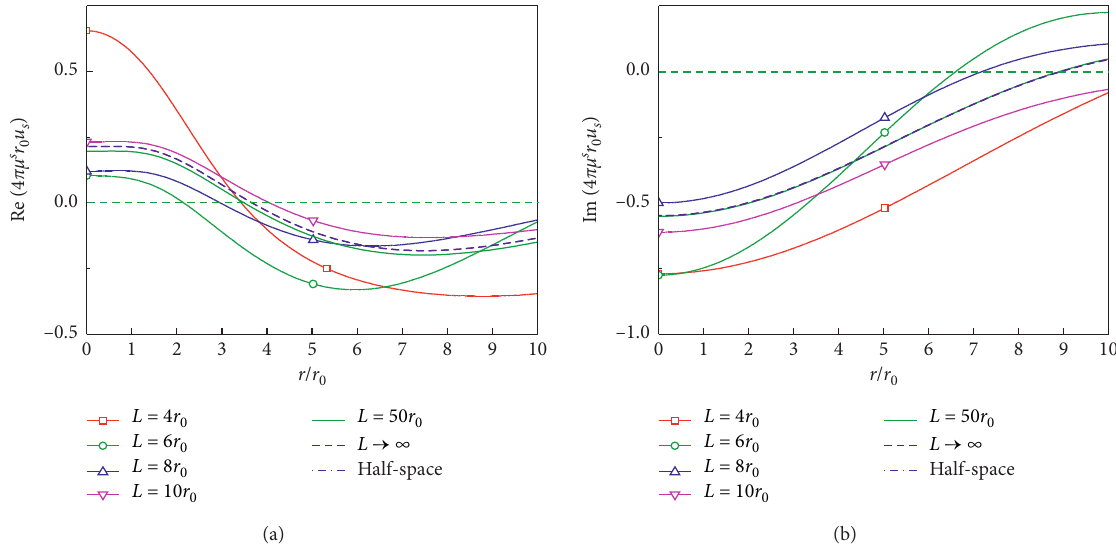
z � 0 induced by unit lateral load on π s at the surface